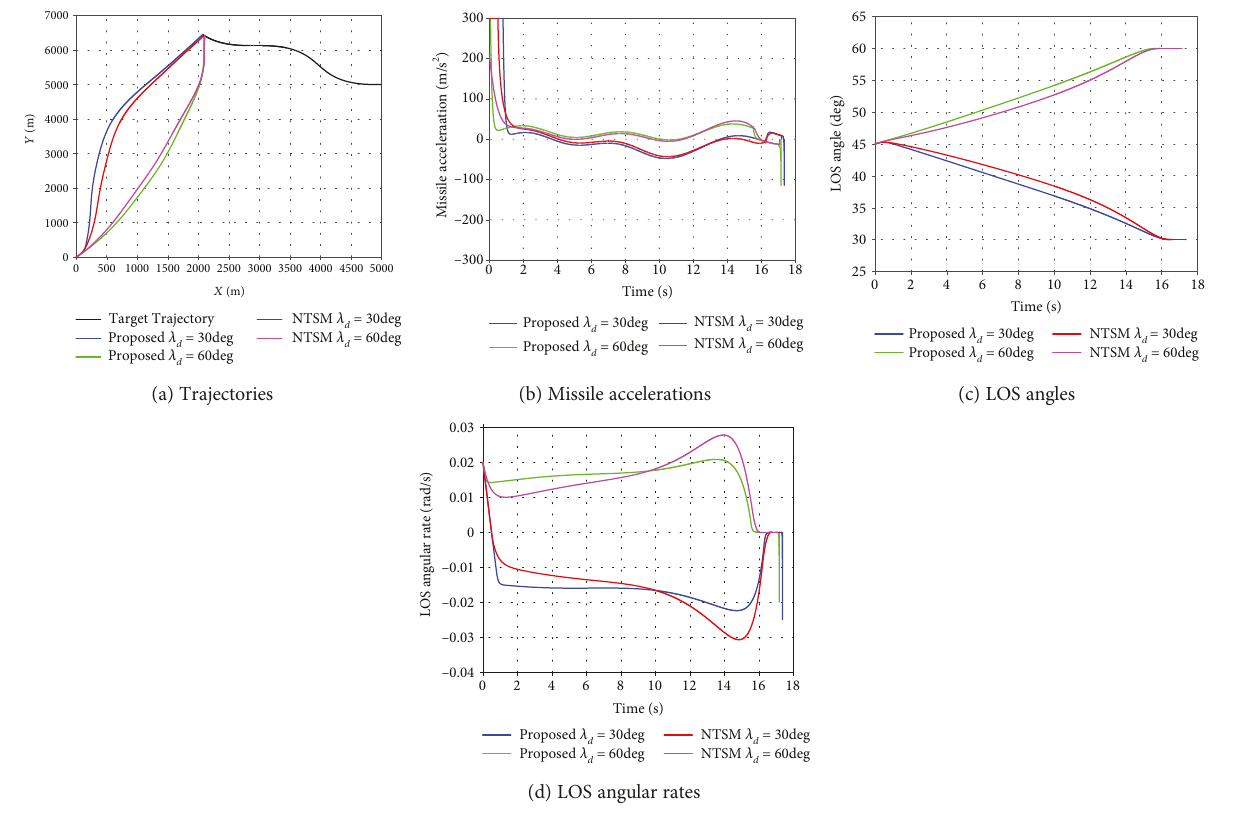
Figure 6: Simulation results of